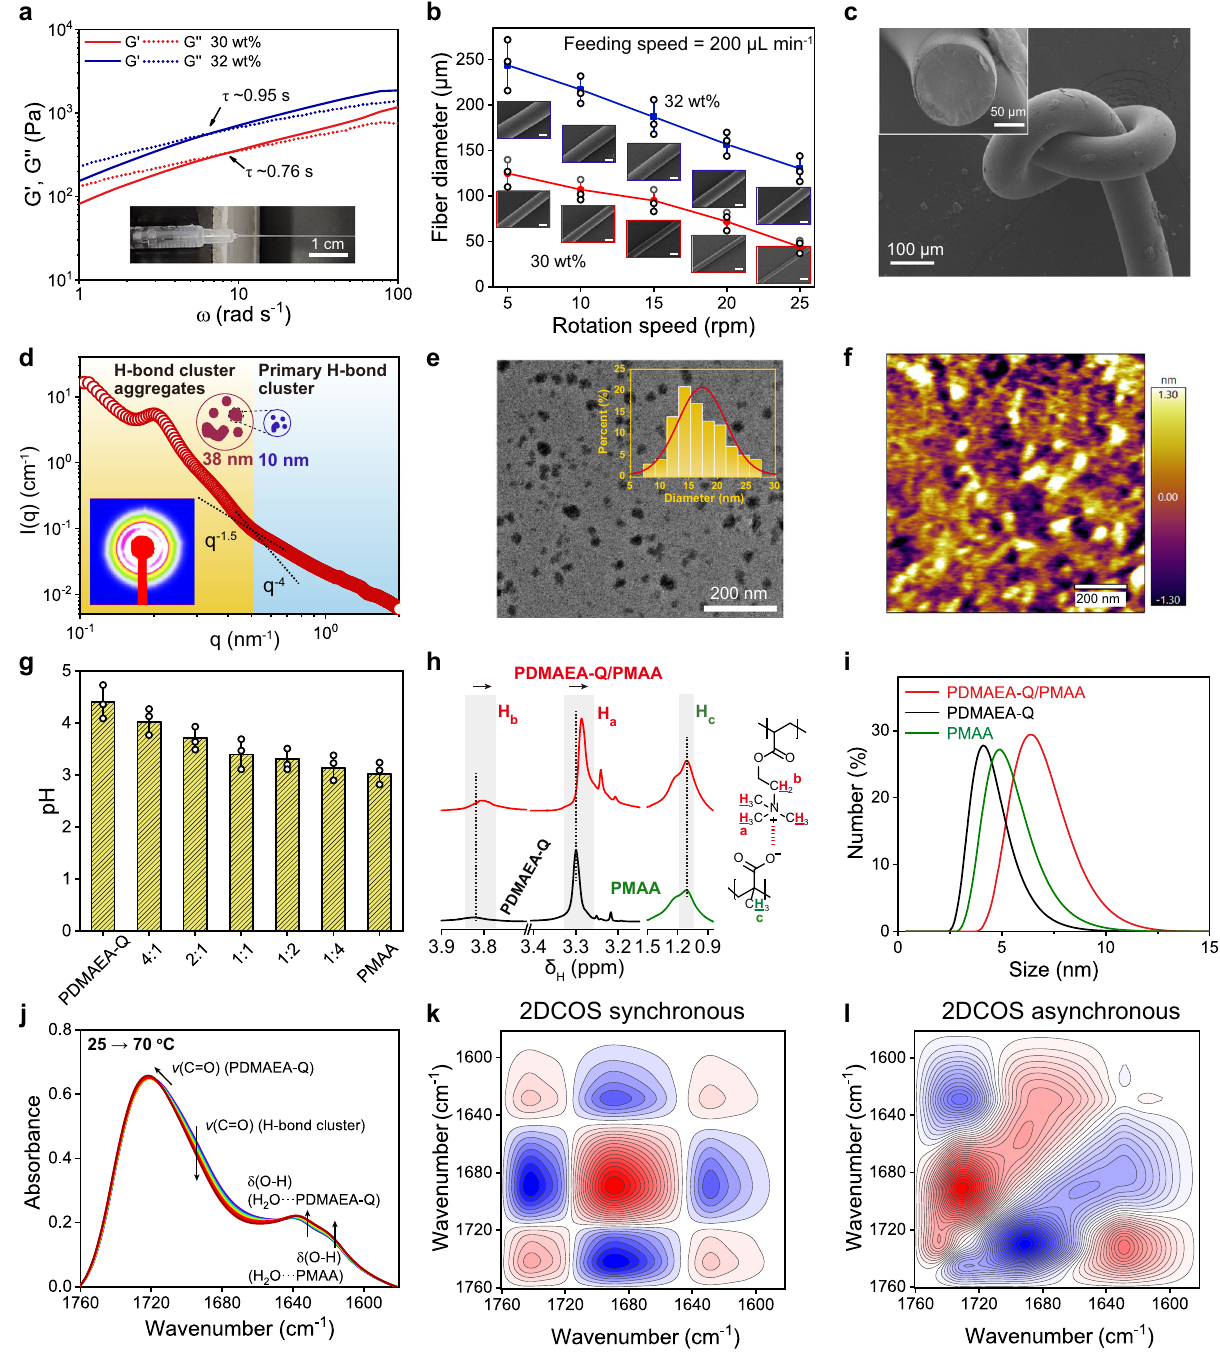
Fig. 2 | Morphology, nanocon fi ned structure, and internal interactions of PDMAEA-Q/PMAA hydrogel micro fi ber. a Rheological behavior of the spinning dopes with different polymer contents ( τ : sol – gel relaxation time). b Fiber dia- meters as a function of rotation speeds and polymer contents in the dope (insets: corresponding SEM images; scale bar = 100 μ m). c , SEM images of a knotted micro fi berandthefracturedcross-section. d SAXScurveand fi ttingresults. e , f TEM andAFMheightimagesshowthepresenceofabundantH-bondclustersandcluster aggregates with the sizes of 8 – 28nm. g pH values of PDMAEA-Q/PMAA mixtures with different DMAEA-Q:MAA molar ratios. h 1 H NMR spectral comparison of